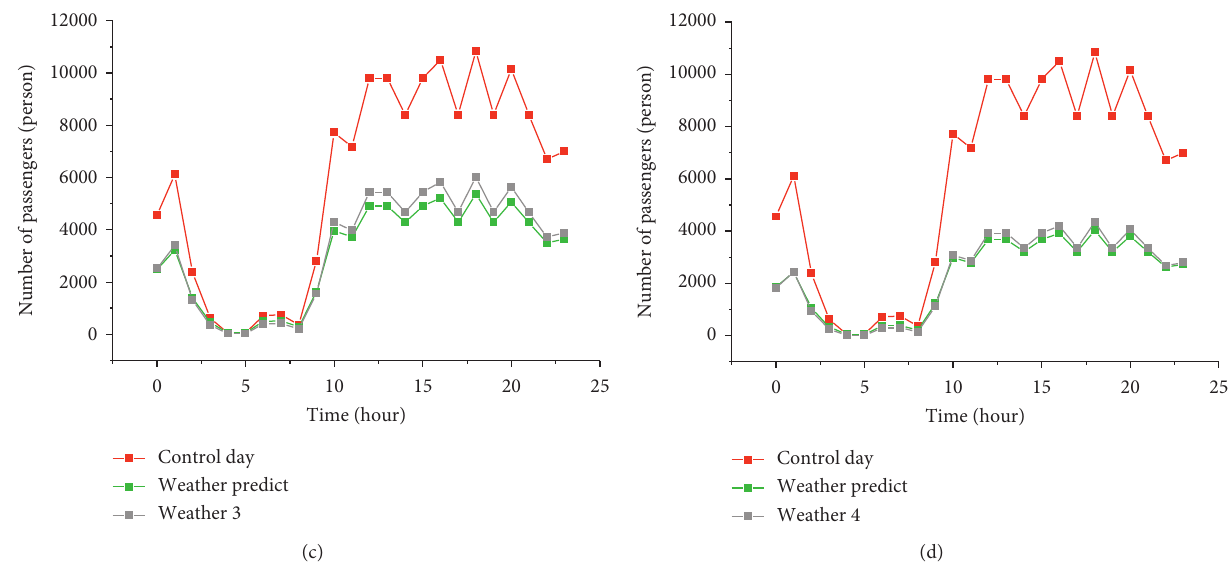
Figure 11: Comparison between data and prediction on holiday condition from level 1 to level